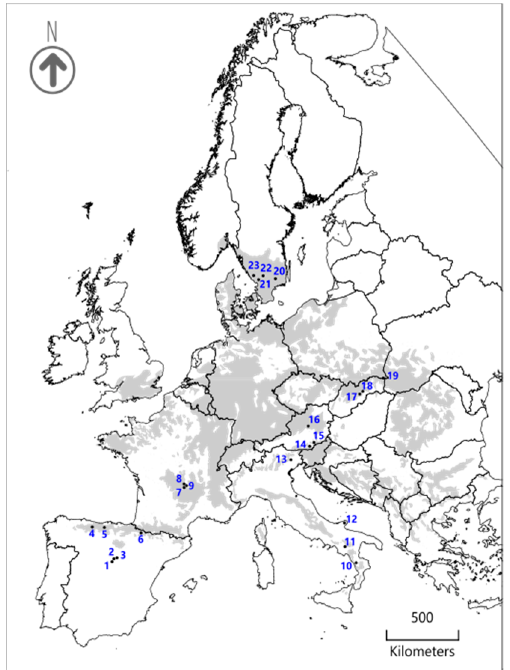
Figure 1. Map of the study area showing the distributional range of Fagus sylvatica (light grey) and the sampling sites (numbers and black dots). Name of the sampling sites in Table S1.